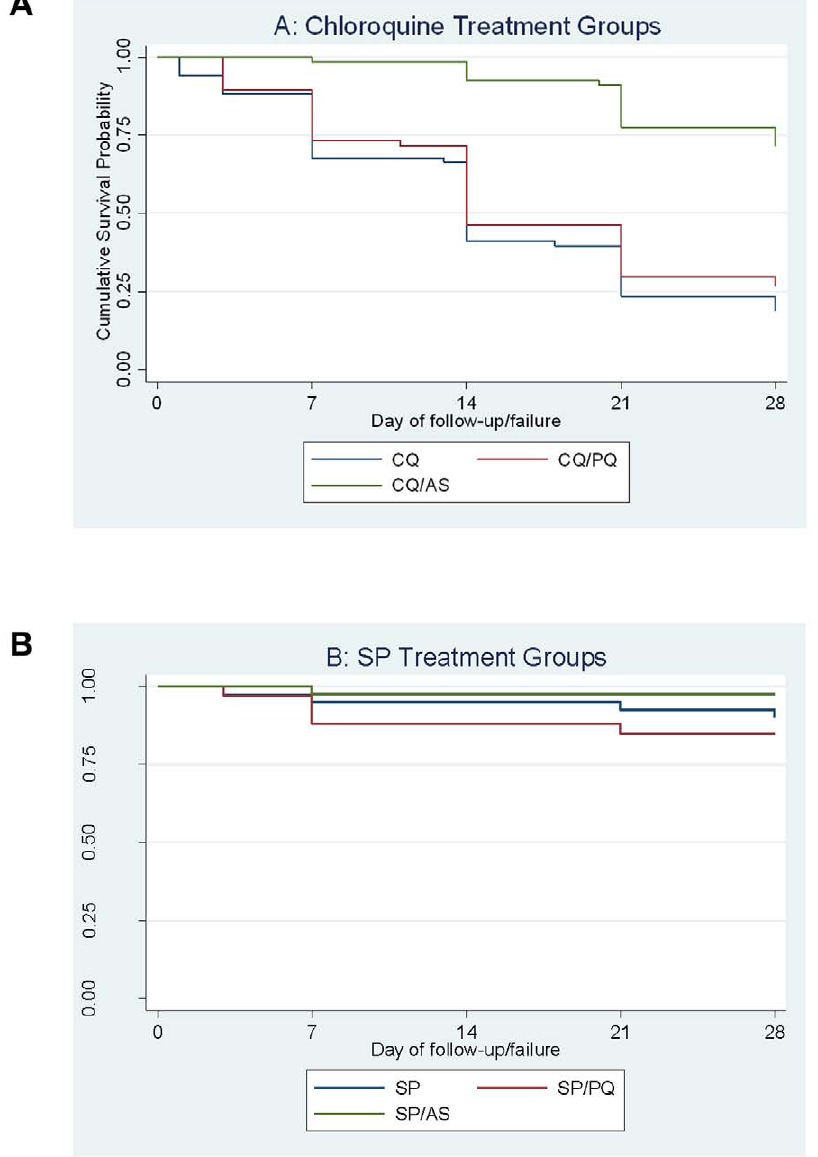
Figure 2. Kaplan Meier survival analysis showing cumulative probability of failure in CQ treatment groups (A) and SP treatment groups (B).